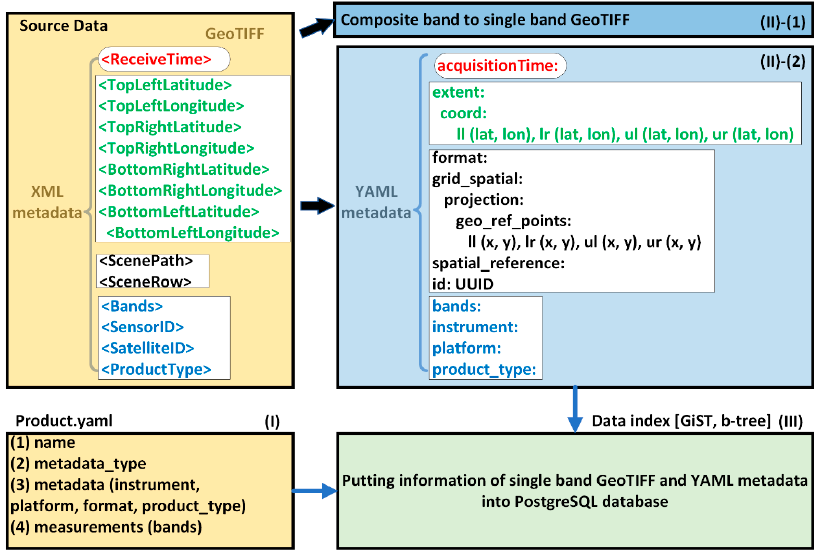
Figure 3. The process from source data to indexed data.